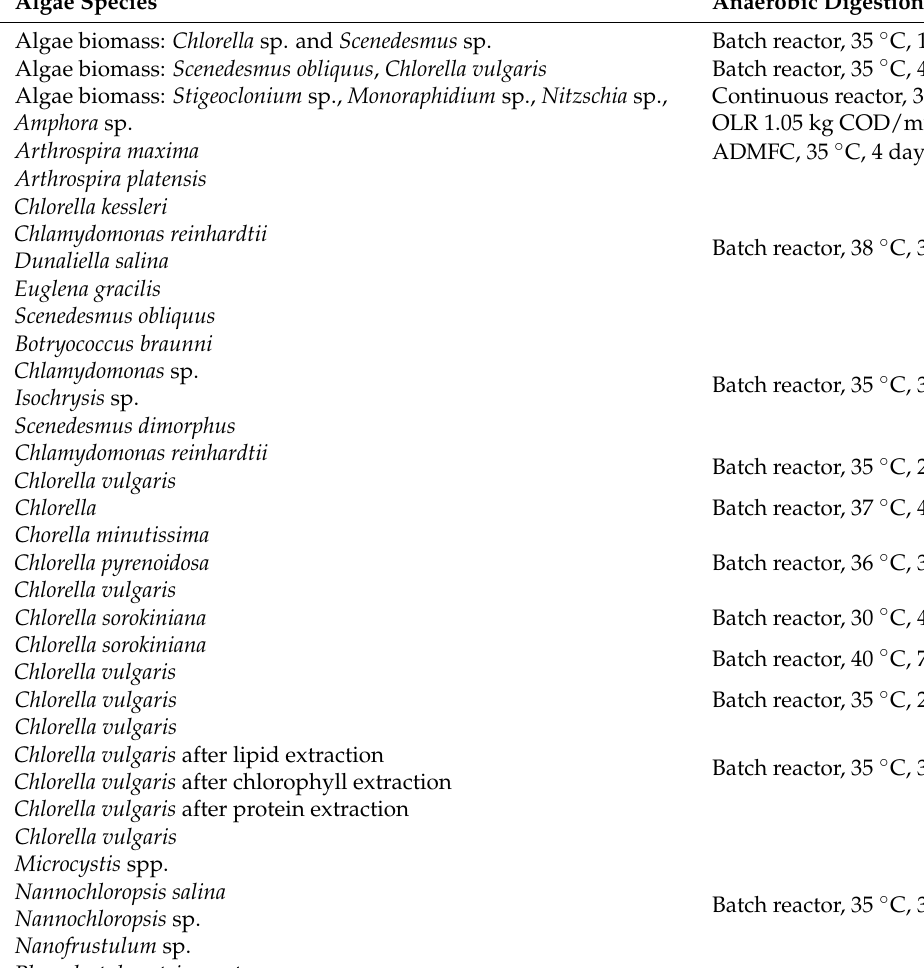
Table 2. Methane yields from mesophilic anaerobic digestion of different microalgae species. Algae